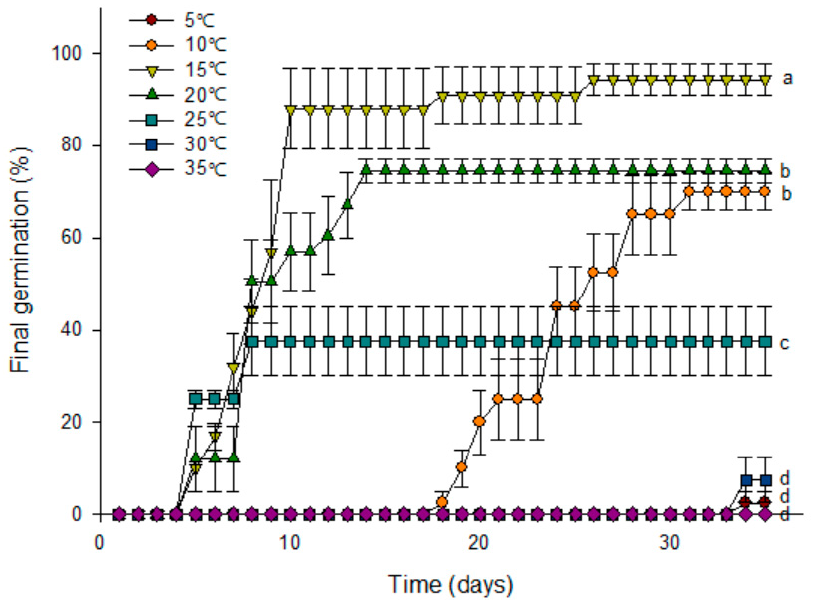
Figure 2. Final germination of P. pusanensis seeds at constant temperature regimes ranging from 5 °C to 35 °C. Bars represent mean ± SE ( n = 4). Same lowercase letters above columns indicate no significant difference ( p < 0.001).